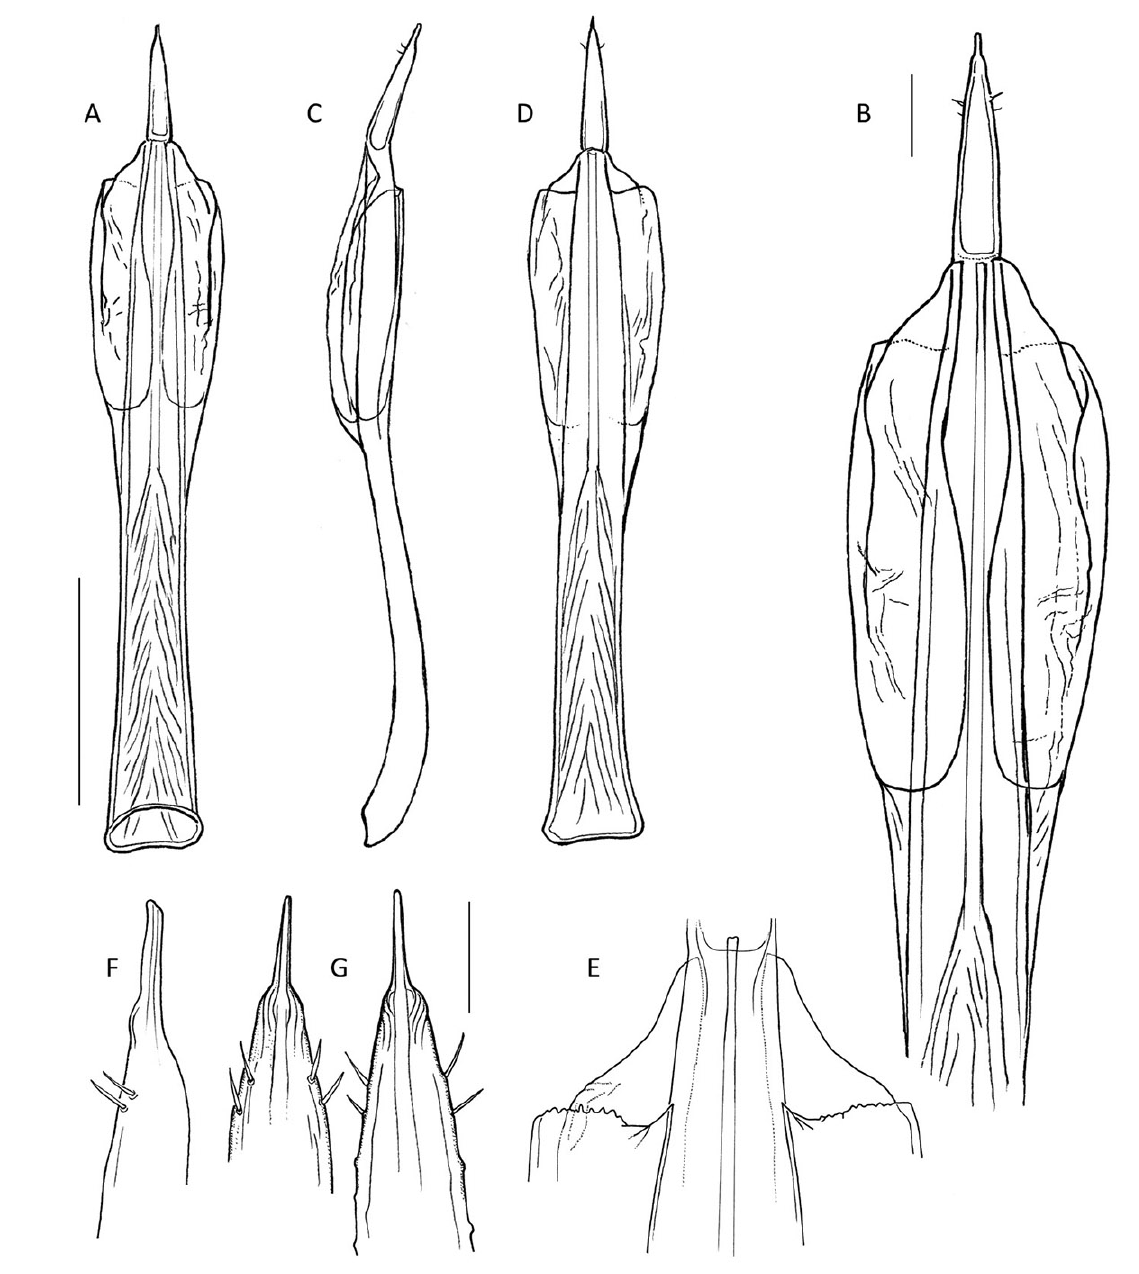
Fig. 6. Penis of Leiolima iberica gen. et sp. nov. A . Ventral view. B . Detail of distal part (ventral view). C . Lateral view. D . Dorsal view. E . Attachment sites of dorsal and ventral membranes (dorsal view). F . Stylus (lateral view, ventral side to left). G . Stylus of two males in ventral (left) and dorsal (right) view. A, G: paratypes, ZUPV 3330 at CHW; B–F: paratype, ZUPV 4261 at CHW. Scale bars: A, C–D = 0.5 mm; B = 0.1 mm; F–G = 0.05